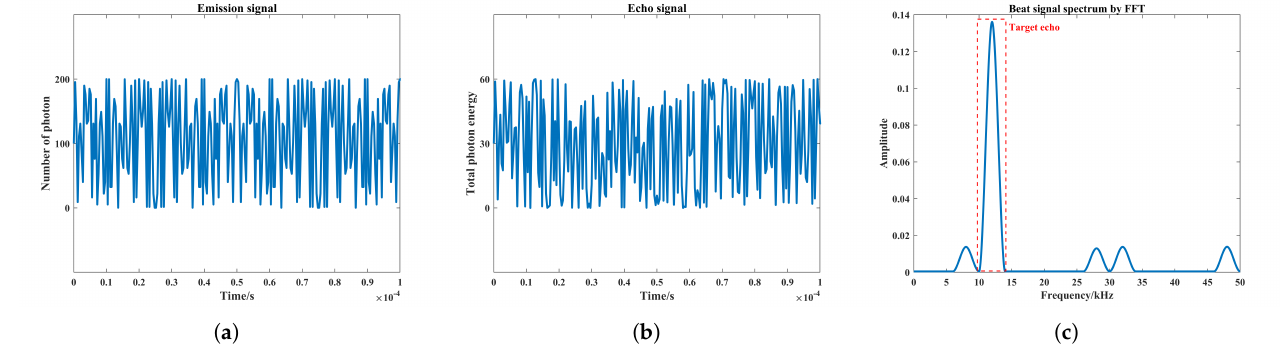
Figure 7. Laser emission signal, echo signal at a target distance of 3 m and beat signal spectrum: ( a ) Laser emission signal, ( b ) echo signal, ( c ) beat signal